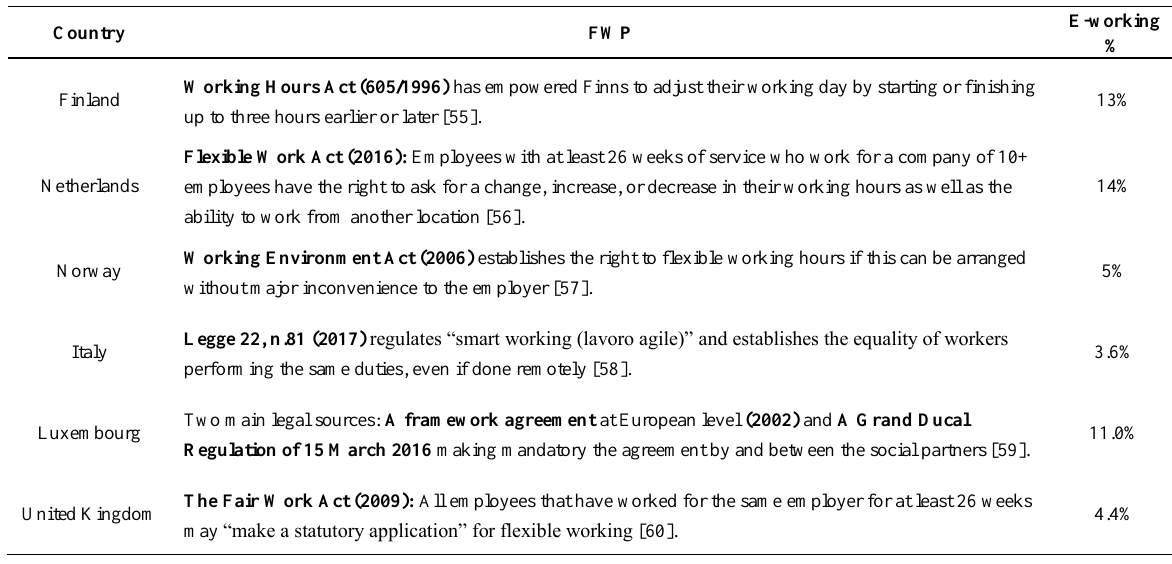
Table 3. Flexible working policies for regular